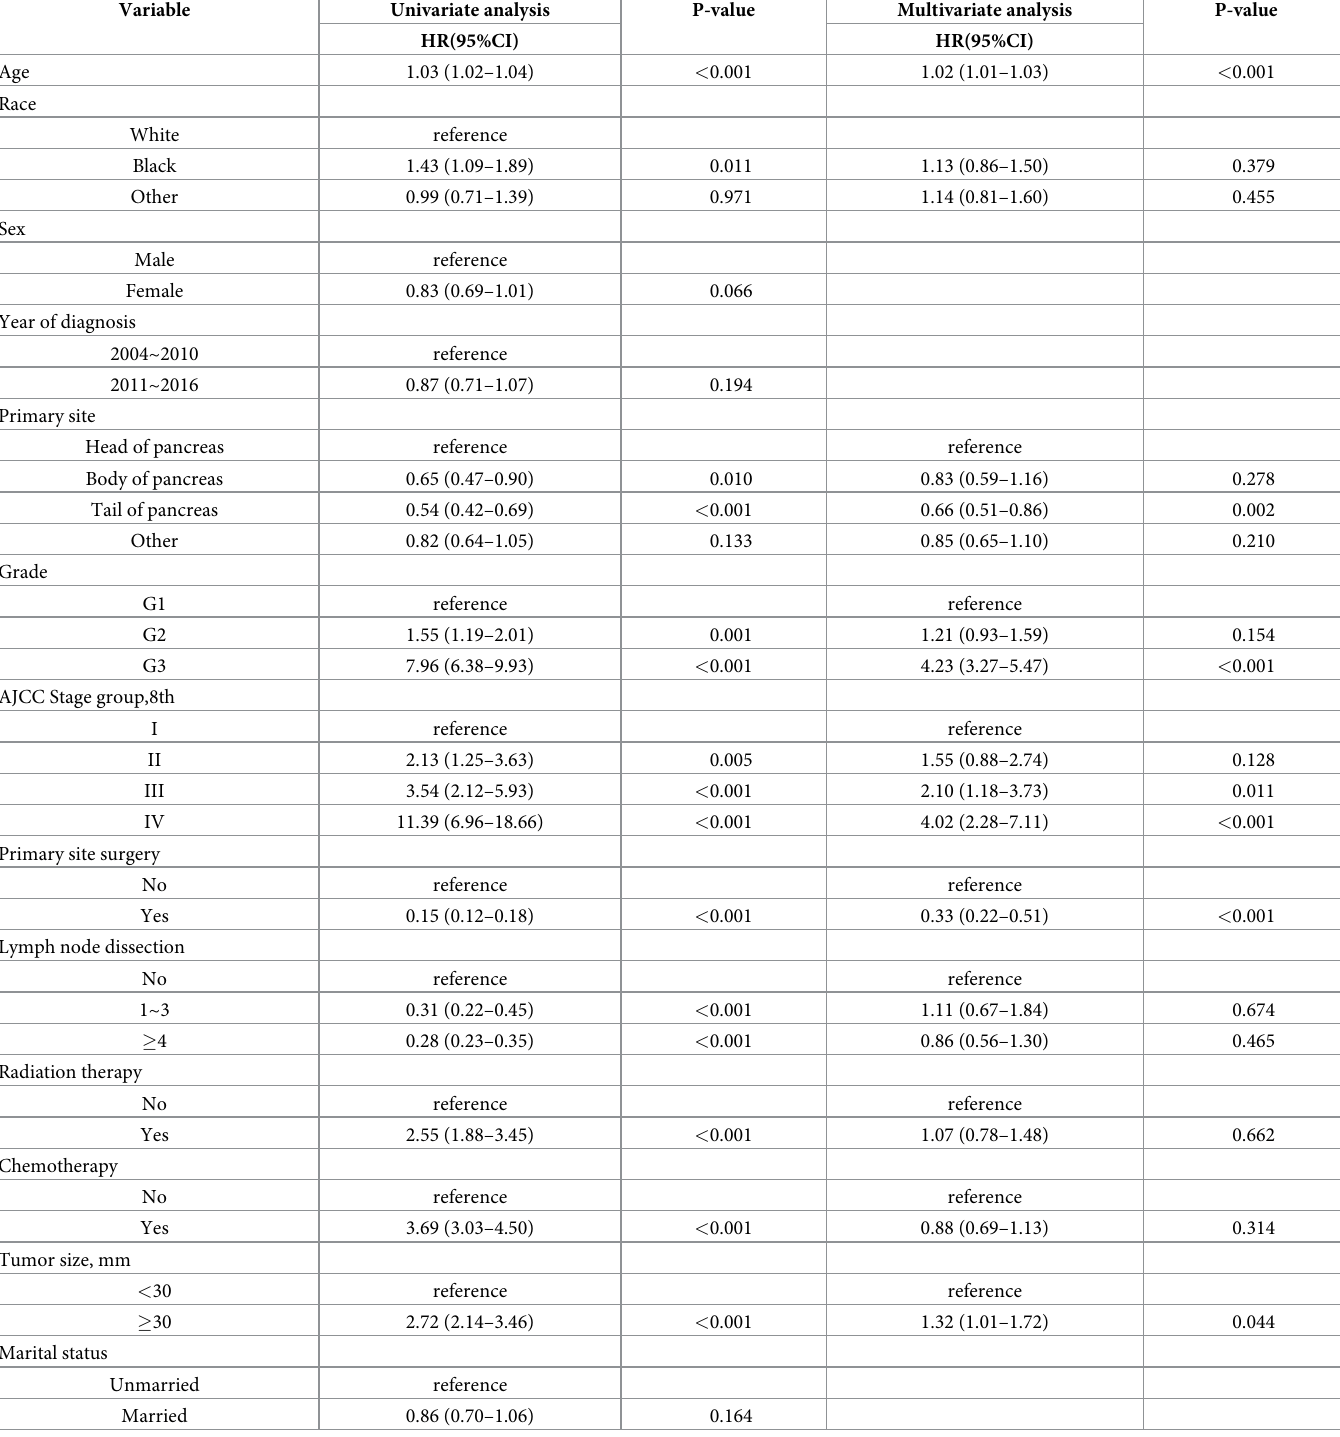
Table 3. Univariate and multivariate Cox regression analysis for OS in NF-pNET patients based on AJCC 8th in training